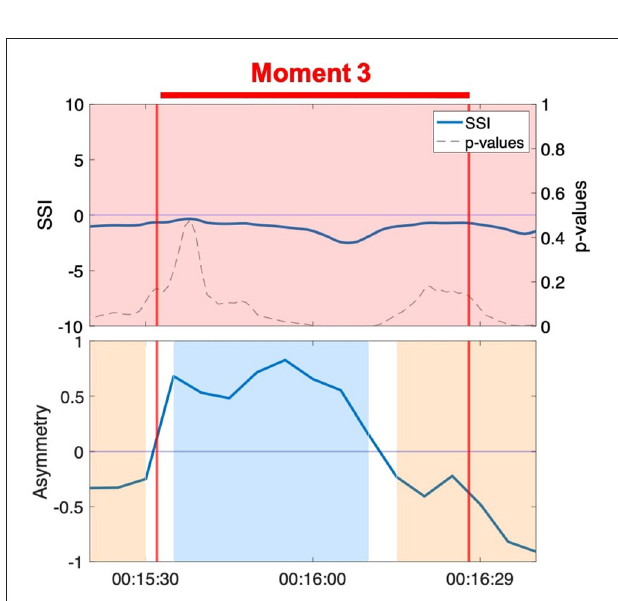
FIGURE 7 | SSI and NSTE asymmetry during Moment 3: Anne and Erica during the resistance sitting